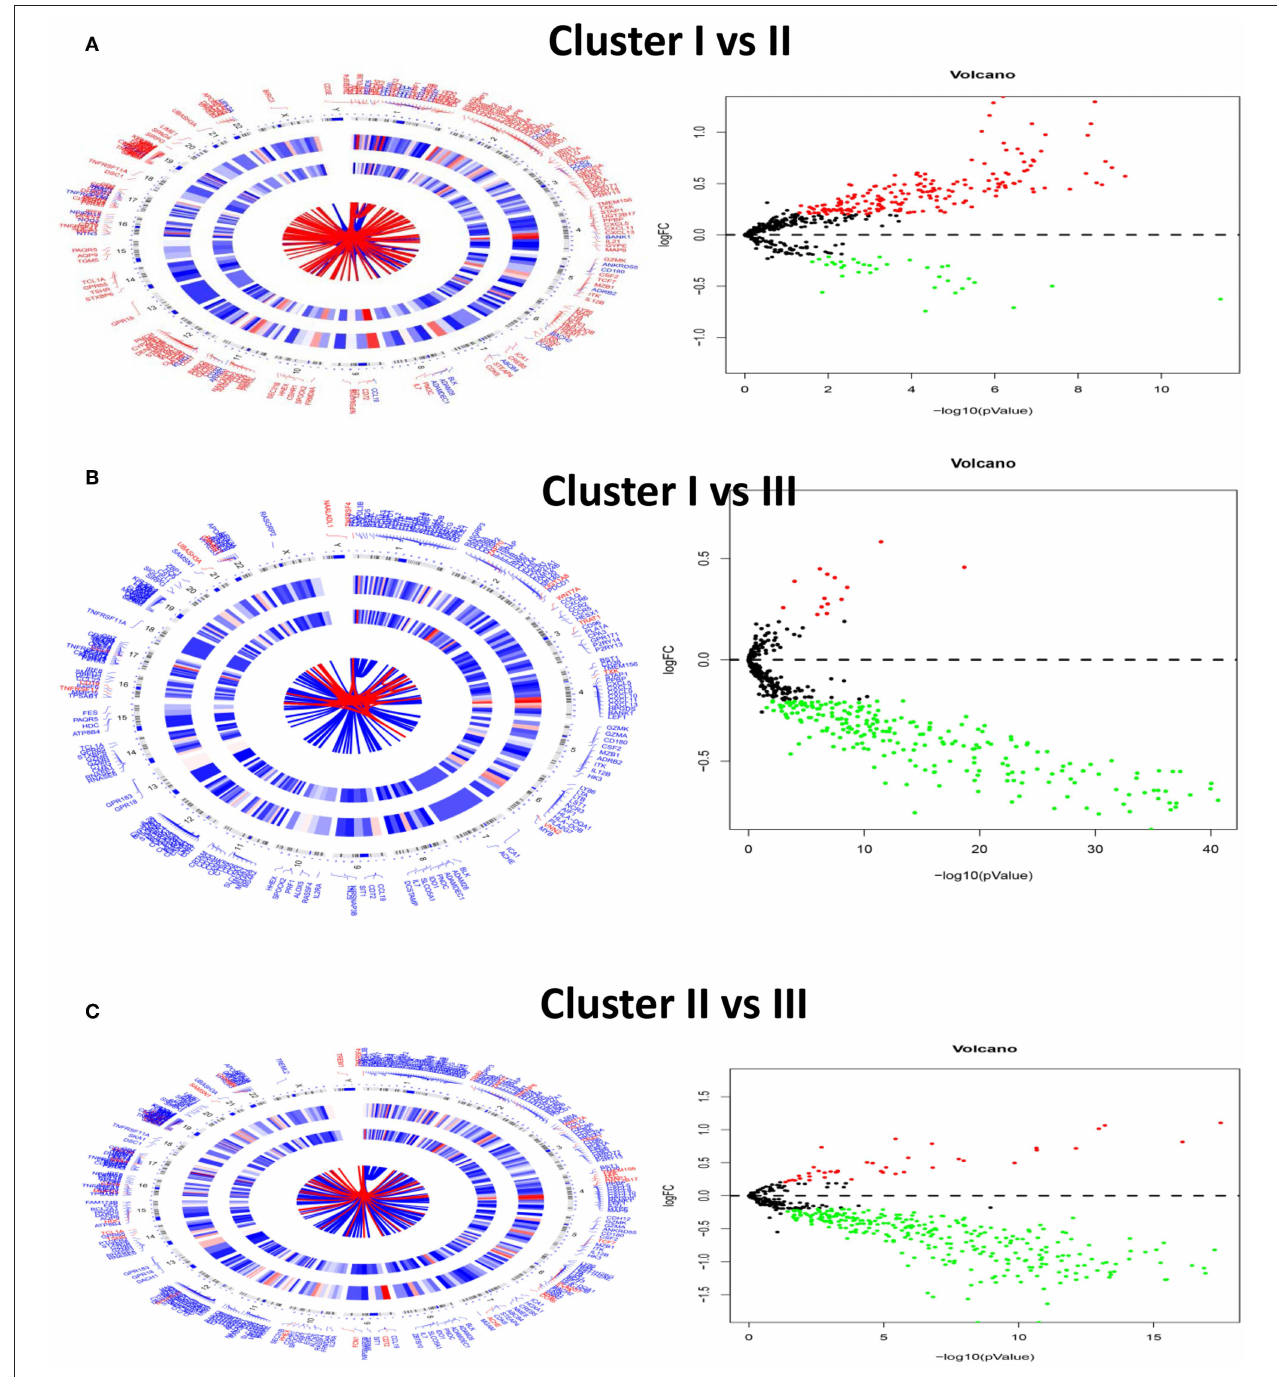
FIGURE 14 | Circular visualization of chromosomal positions, hierarchical clustering, connectivity and severity gradients (Left) and a volcano plot (Right) in HNC subgroups. (A–C) Is for cluster I vs. Cluster II, cluster I vs. cluster III and cluster II vs. Cluster